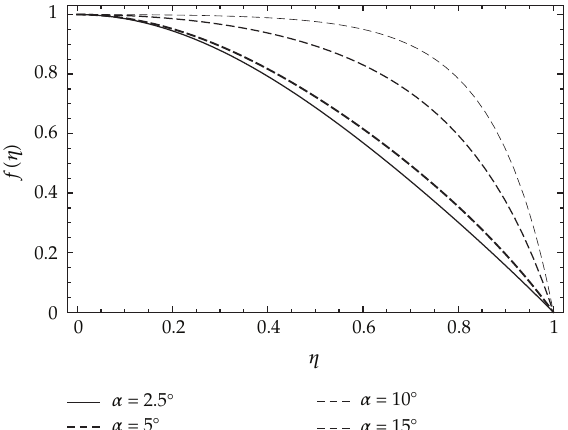
Figure 6: DTM solution for velocity in divergent channels for Re (cid:8) 100 and H (cid:8) 1500.